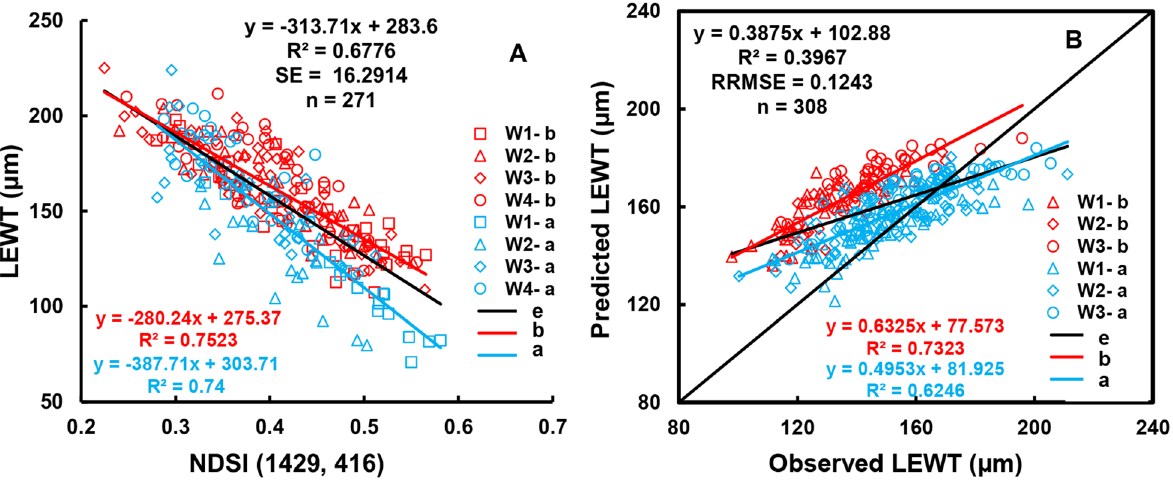
Figure 9. Quantitative relationships between (R 1429 2 R 416 )/(R 1429 + R 416 ) and LEWT (A); the 1:1 relationship between the predicted and observed LEWT on (R 1429 2 R 416 )/(R 1429 + R 416 ) in wheat (B).